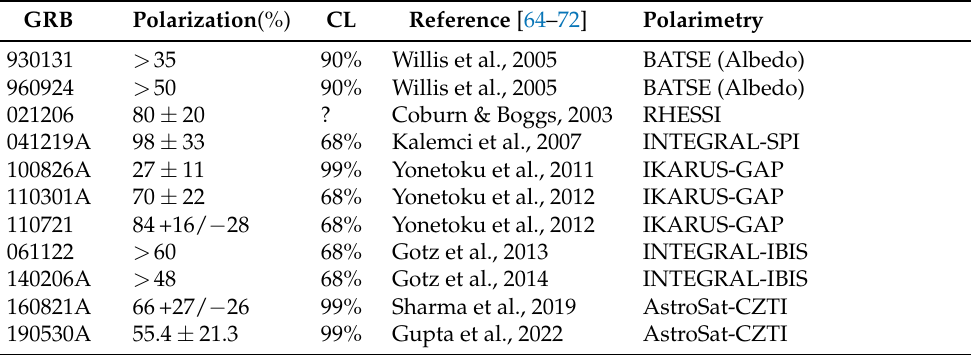
Table 1. GRBs with measured γ -ray polarization during the prompt